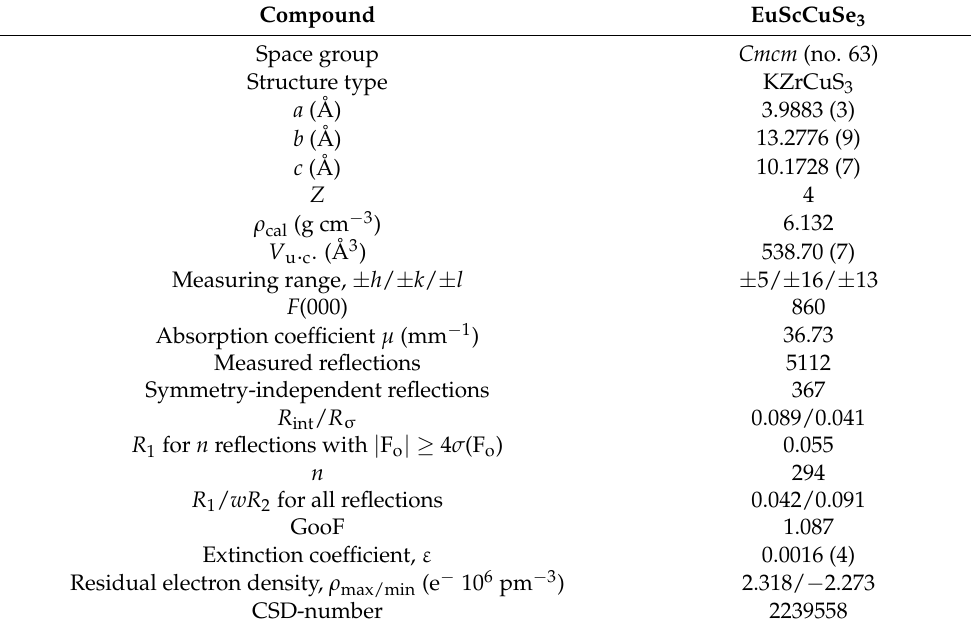
Table 1. Crystallographic data for EuScCuSe 3 and their determination.